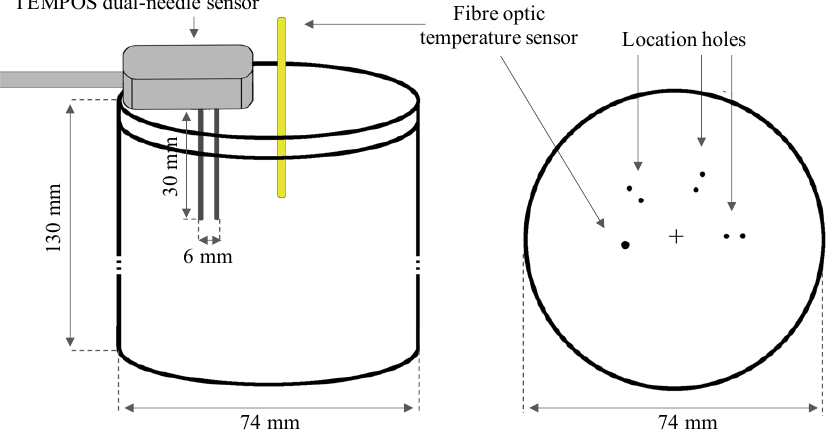
Figure 2. Sketch of the container used to hold the samples, with the related dimensions. Left : The dual-needle SH-3 sensor from the TEMPOS thermal properties analyser is sketched. The sensor was placed at least 15 mm from the border of the container, according to the manufacturer’s specification. A fibre optic temperature sensor used to monitor the temperature during the experiment is also shown. Right : The container’s lid is sketched together with the holes dedicated to the insertion of the SH-3 sensor and the fibre optic temperature sensor